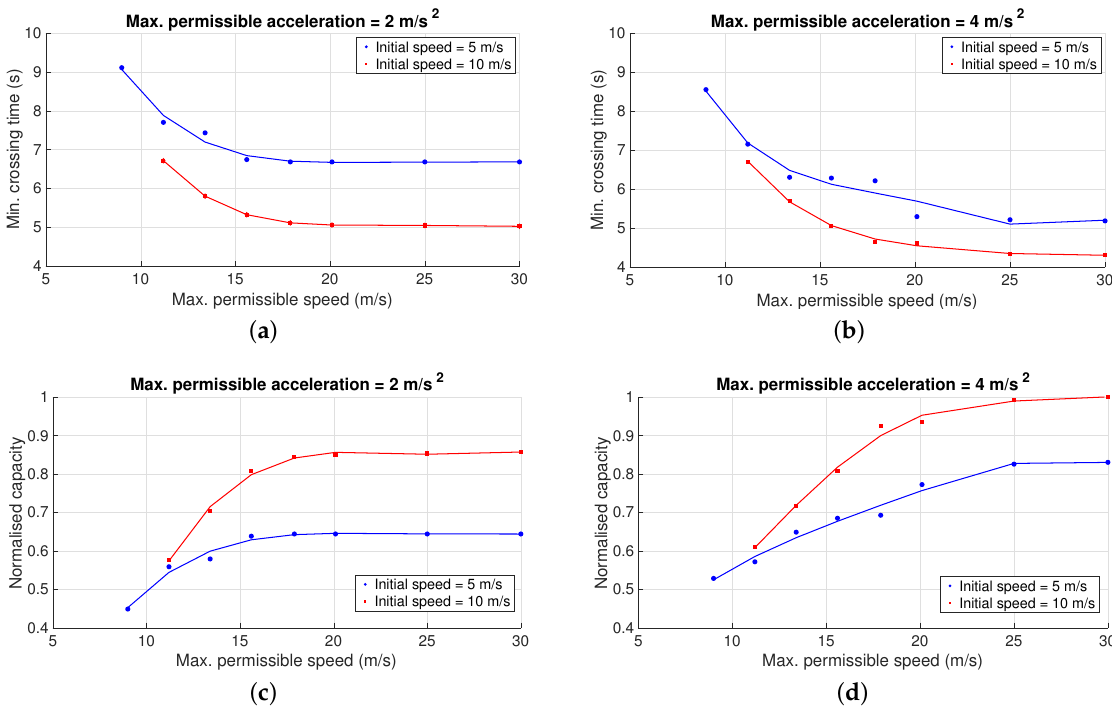
Figure 5. Variations of the crossing time when ( a ) Max. permissible acceleration is 2 m/s 2 and ( b ) Max. permissible acceleration is 4 m/s 2 and variations of capacity when ( c ) Max. permissible acceleration is 2 m/s 2 and ( d ) Max. permissible acceleration is 4 m/s 2 of the studied lane-free intersection over different values of the initial speed and the maximum permissible speed of CAVs. The solid lines are the corresponding fitted polynomials of order four, which show the variation